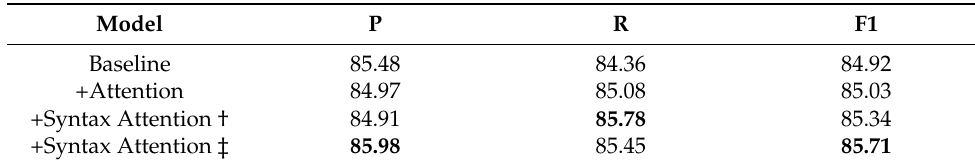
Table 5. Ablation trials on the ACE2005 dataset. † indicates the use of a soft-pruning strategy and ‡ indicates the use of a hard-pruning